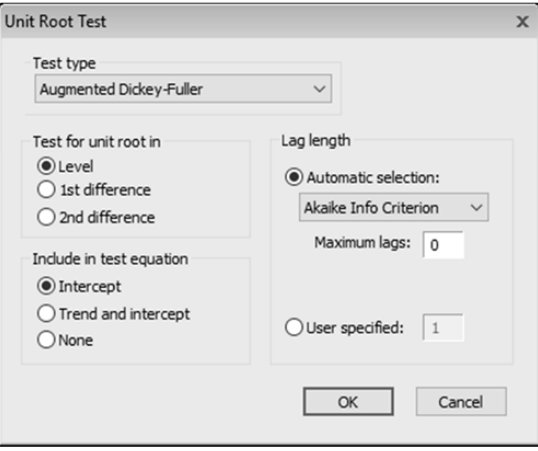
Figure 1. Performing Augmented Dickey–Fuller (ADF) test in EViews.